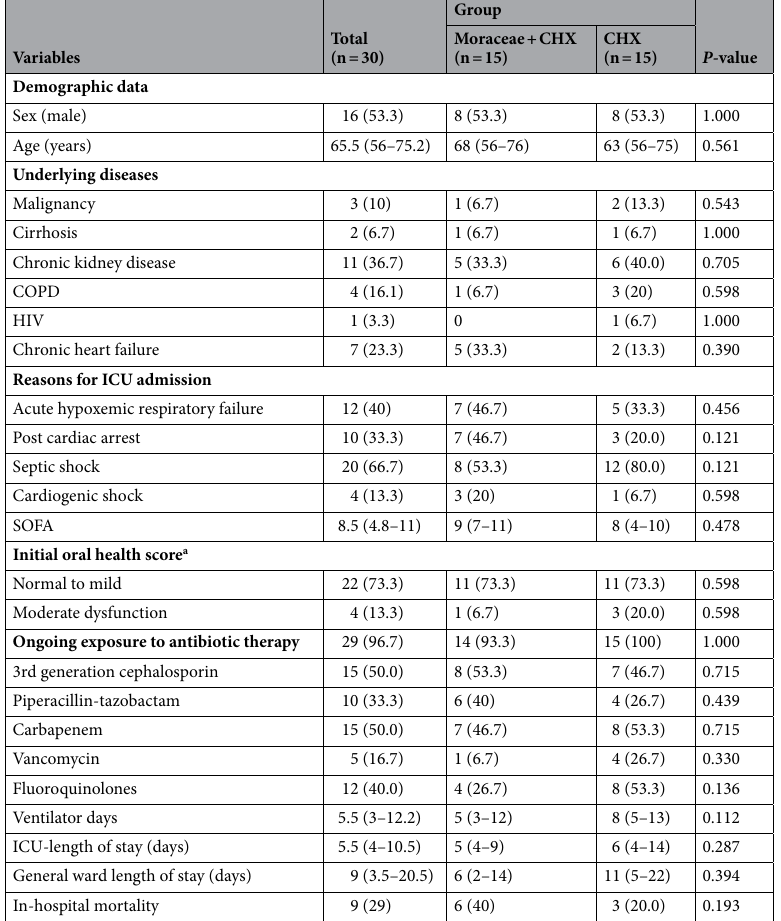
Table 1. Baseline characteristics of the patients. Data are presented as the median (interquartile range) or n (%). CHX, chlorhexidine; COPD, chronic obstructive pulmonary disease; HIV, human immunodeficiency virus; ICU, intensive care unit; SOFA, sequential organ failure assessment. a Missing data of 4 patients were due to technical errors and lost